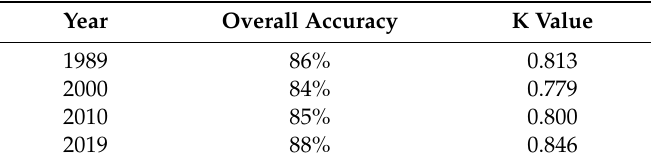
Table 3. Overall accuracy and K values of the classified Landsat images (1989, 2000, 2010 and 2019).